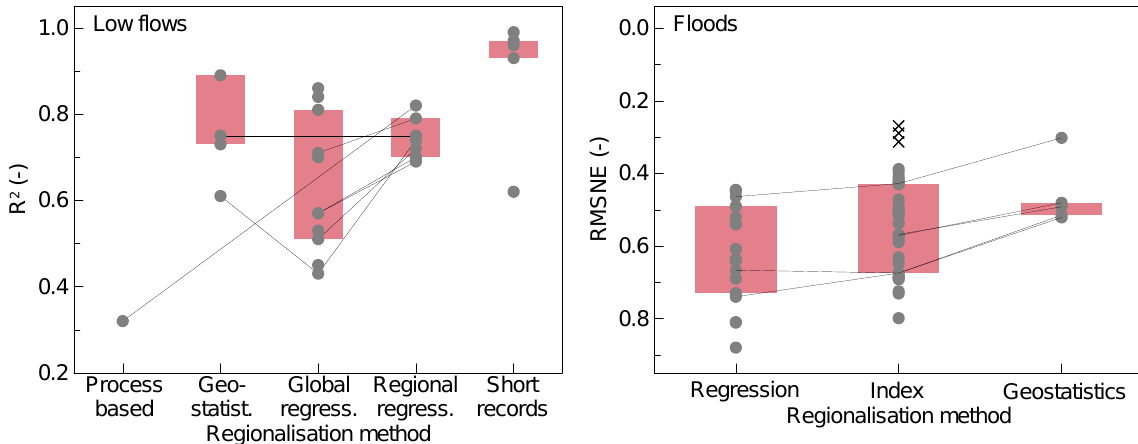
Fig. 3. Coefficient of determination of predicting low flows in ungauged basins (left) and root mean squared normalised error of predicting floods in ungauged basins (right), stratified by regionalisation method (Level 1 assessment). Each symbol refers to a result from the studies in Tables 1 and 3. Circles represent performances calculated on specific discharges (m 3 s − 1 km − 2 ) , crosses represent performances calcu- lated on discharges (m 3 s − 1 ) . Lines indicate studies that compared different methods for the same set of catchments. Boxes show 25–75%